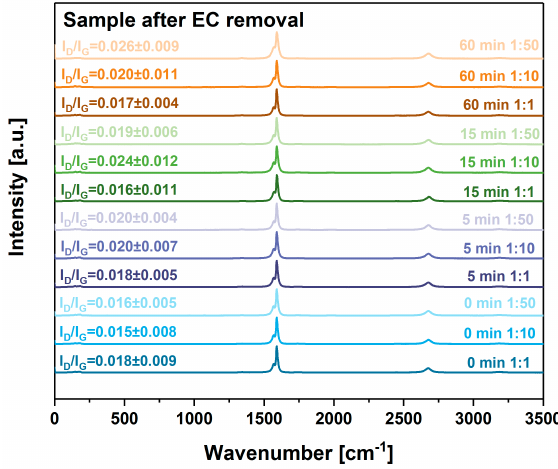
Figure 5. The influence of grinding time and EC content on crystallinity of CNT films after binder removal as gauged by Raman spectroscopy.